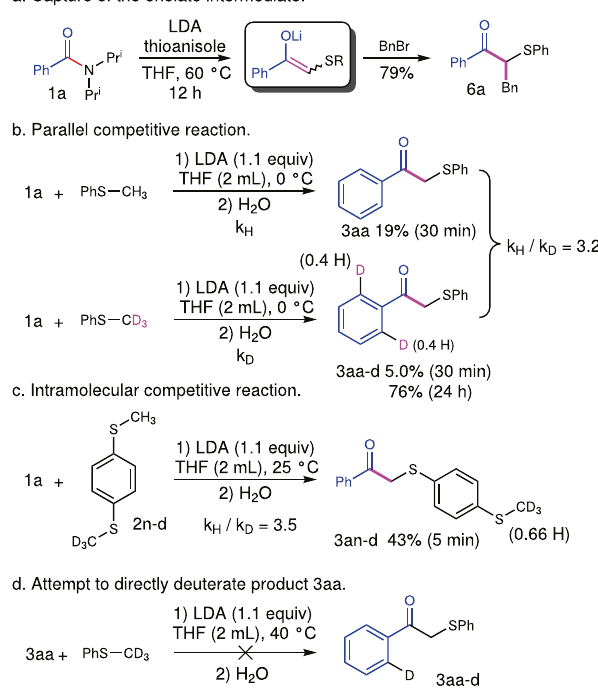
Fig. 4 Control Experiments. a Capture of the enolate intermediate. b Parallel competitive reaction. c Intramolecular competitive reaction. d Attempt to directly deuterate product 3aa .